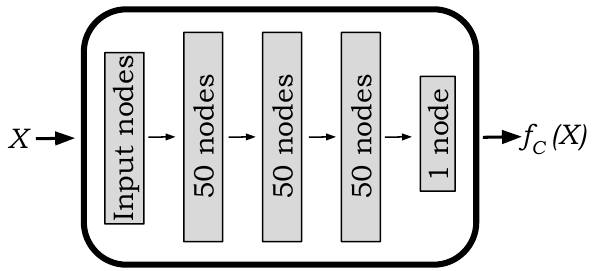
Figure 3: Many of the methods explored in this paper use a neural network classifier. For consistency, we always use a network with three hidden layers, each of which has 50 nodes and uses the ReLu activation function. The output is a single node with a sigmoid activation function. Our input data are the 11 τ phase space shown in Eq.